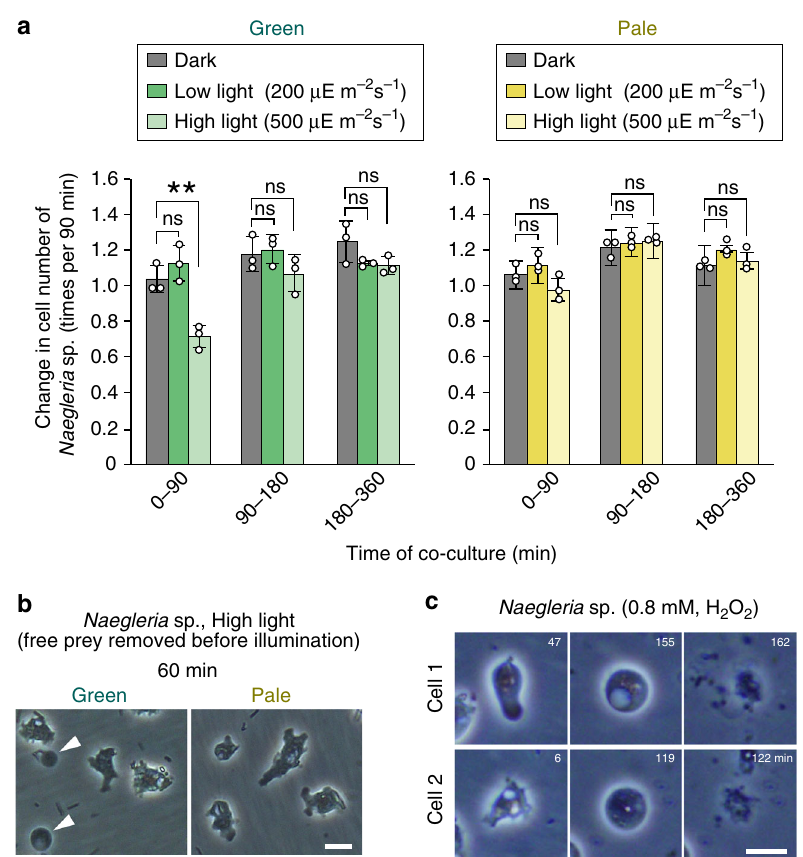
Fig. 2 Effect of the photosynthetic trait of bacterial prey and light on Naegleria sp. growth. Naegleria sp. feeding on green or pale S . elongatus under dark conditions was either cultured in the dark or transferred to low- (200 μ E m − 2 s − 1 ) or high-light conditions (500 μ E m − 2 s − 1 ). a Changes in growth rate of Naegleria sp. cells (fold change of the cell number per 90 min) in respective conditions. The error bar represents s.d. of three independent cultures (cultured at the same time). * p < 0.05; ** p < 0.005; ns, not statistically signi fi cant ( t -test). Changes in number of Naegleria sp. cells in respective conditions, from which the growth rate was calculated, are shown in Supplementary Fig. 2. Source data are provided as a Source Data fi le. b Microscopic images of Naegleria sp. cells 60 min after transfer to high-light conditions. Just before illumination, free bacterial prey was removed. Arrowheads indicate round dying cells. c Microscopic images of Naegleria sp. cells after treatment with 0.8 mM H 2 O 2 under dark conditions. Two independent cells are shown. Scale bars = 10 μ